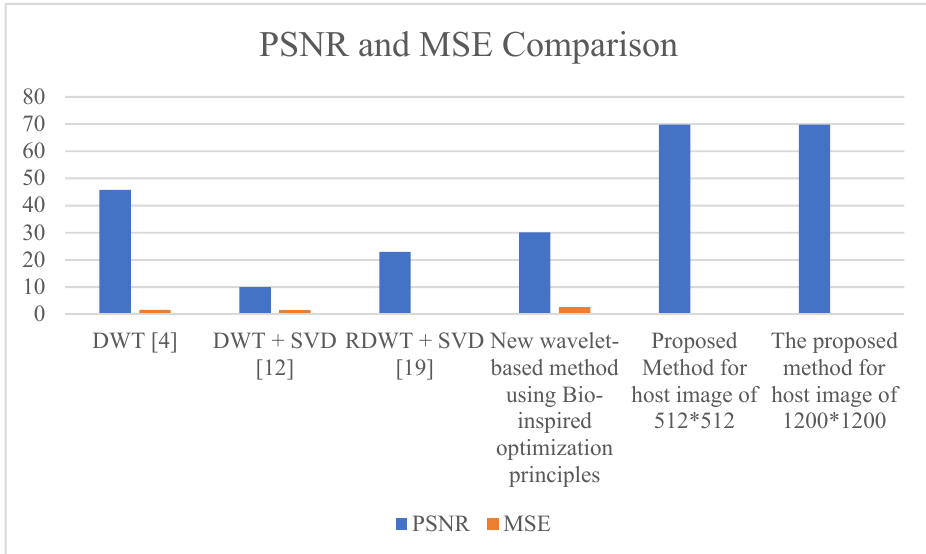
Figure 19. PSNR and MSE comparisons.